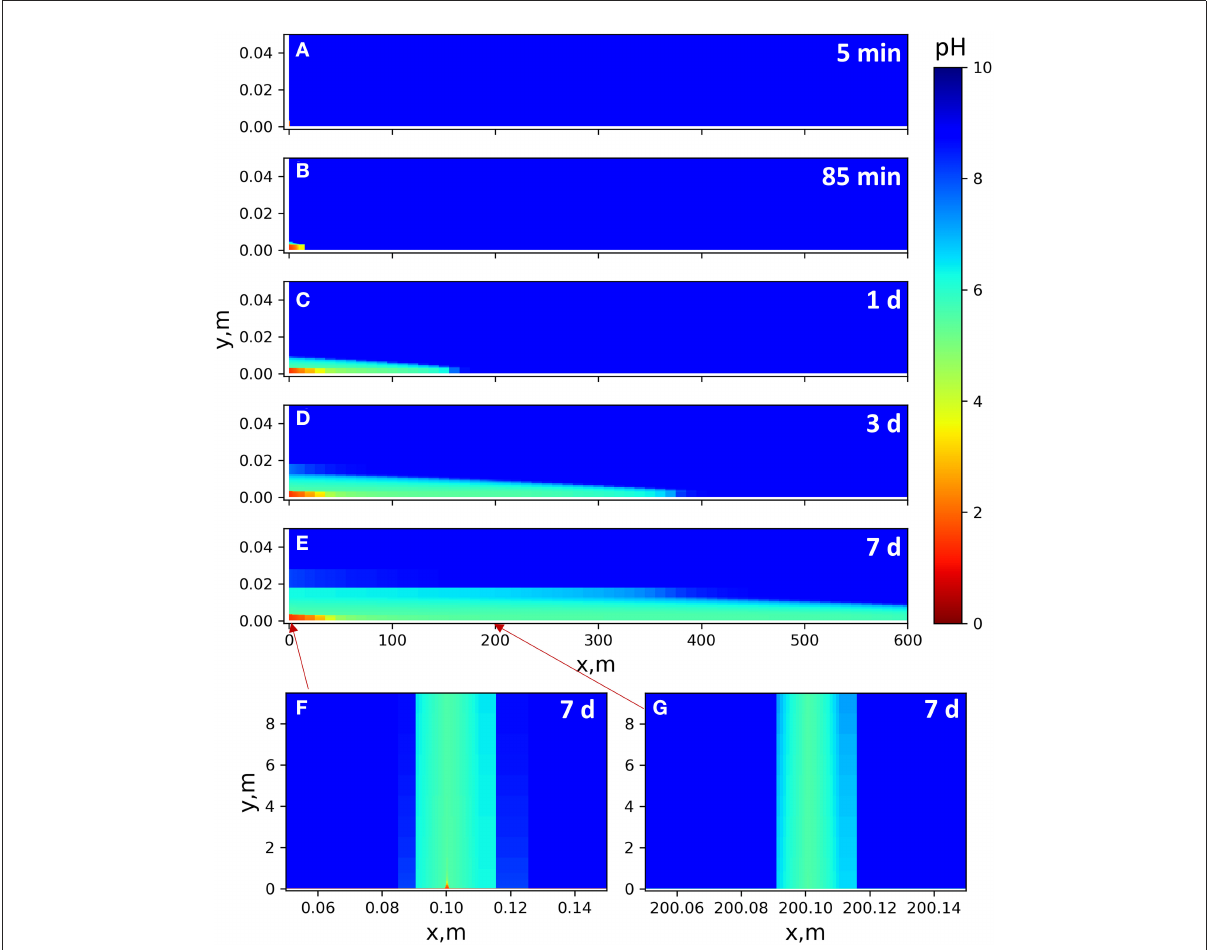
FIGURE4 pH gradients in the 2D pre-mixed models with continuous injection of a pH 1.45 solution. There is no flow in the shale matrix. pH gradients in the shale matrix are due to ion diffusion. (A–E) Time-resolved results for pH alteration close to the main fracture (y direction shown up to